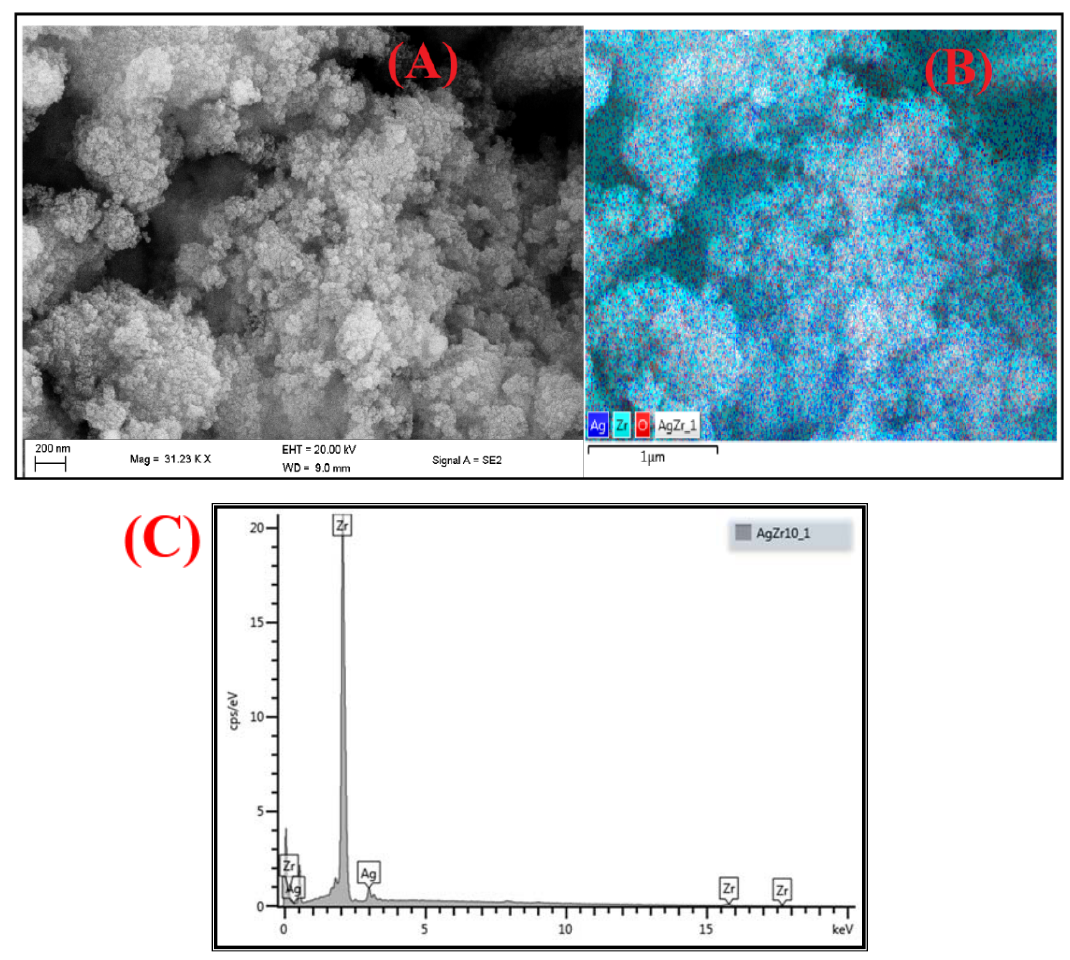
Figure 3. ( A ) SEM micrograph; ( B ) SEM mapping; ( C ) EDS spectra of 2.5% Ag 2 O–ZrO 2 catalyst.